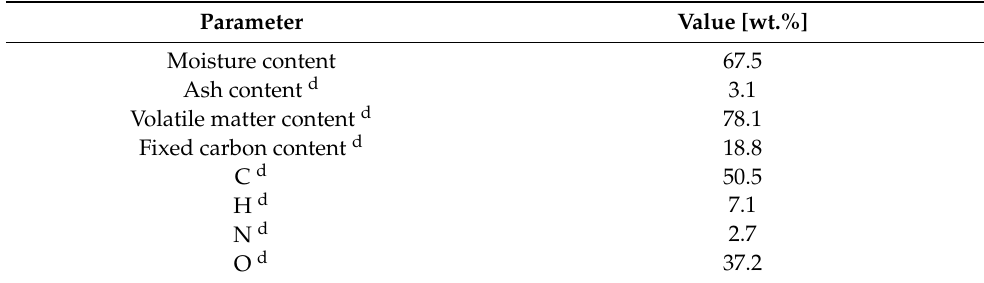
Table 1. Raw blackcurrant pomace